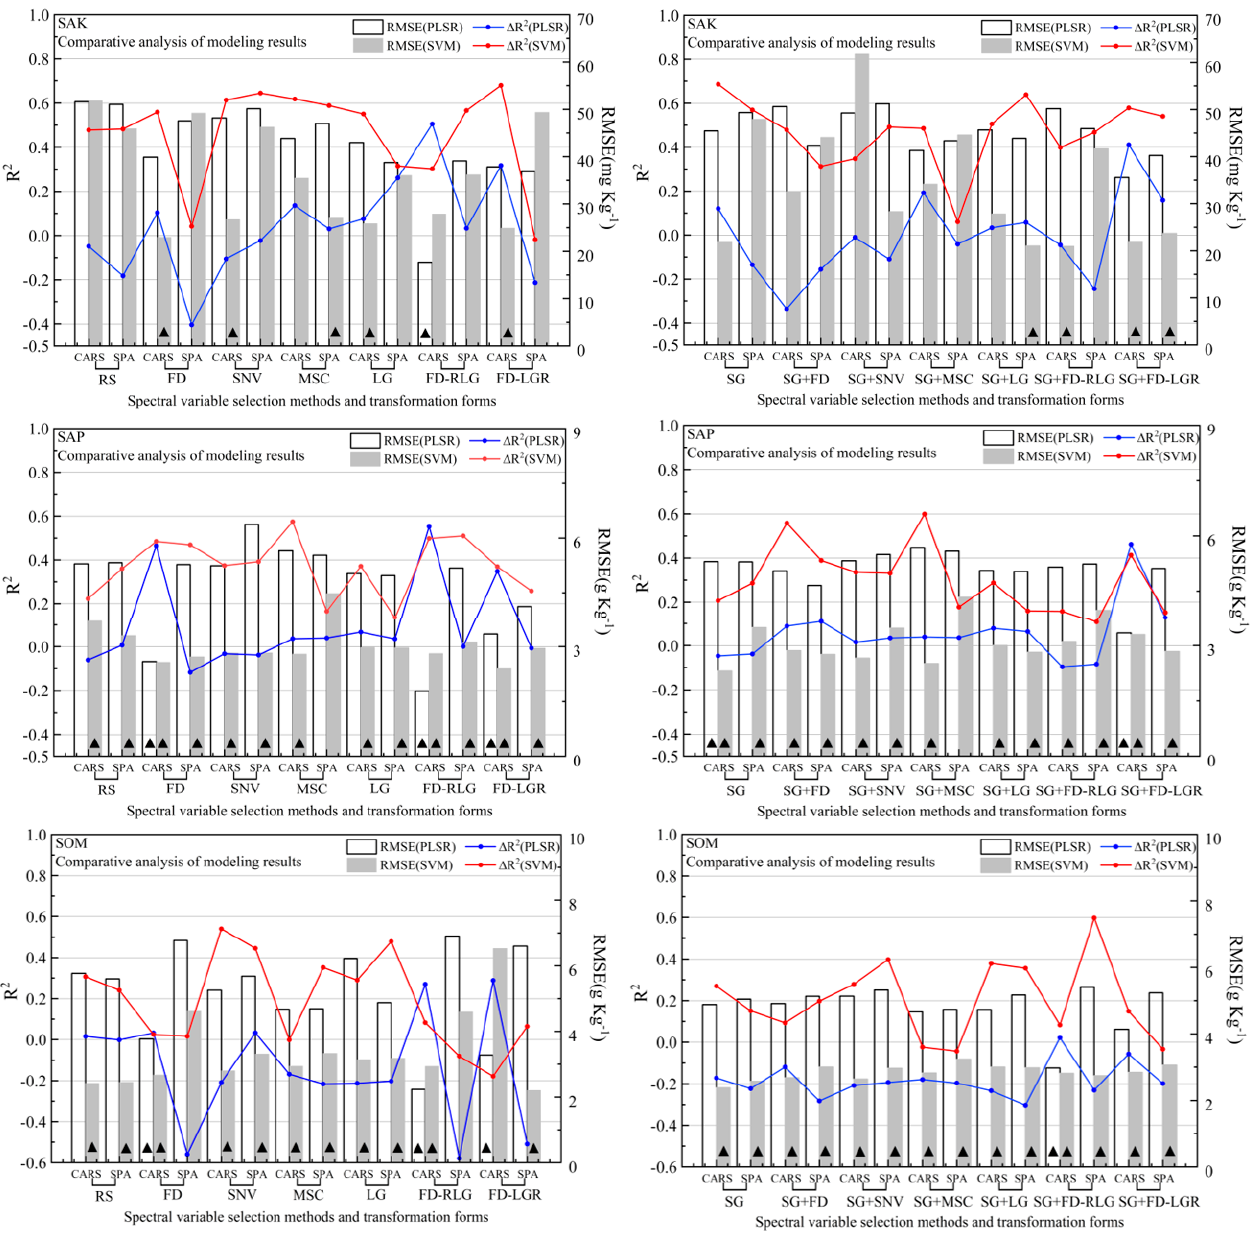
Figure 6. Independent validation results for three soil nutrient (SAK, SAP, and SOM) estimations under different spectra pre-processing transformation methods and spectral variable selection methods. ( ∆ R 2 : calibration model R 2 , prediction result of R 2 . ▲ represents the model belonging to category C (RPD > 2) with good accuracy.)